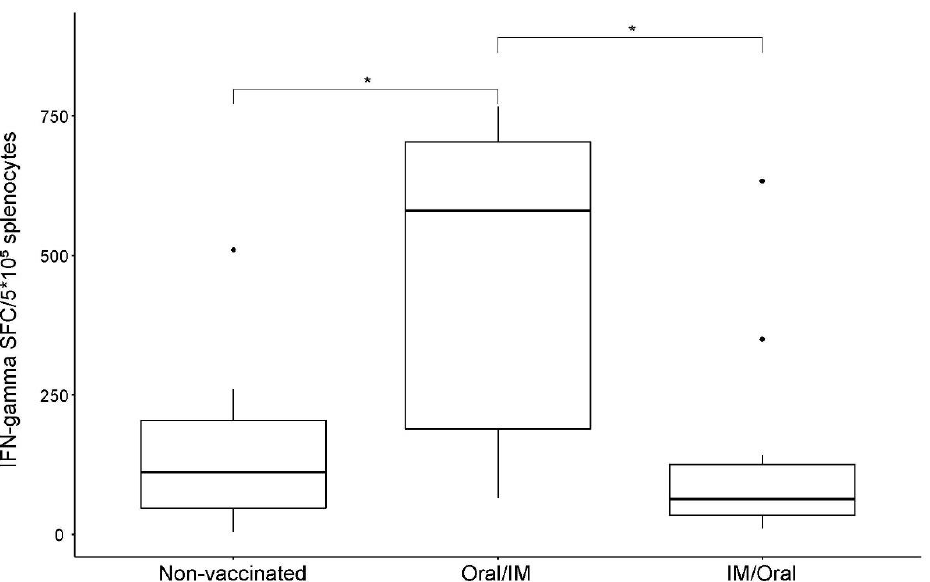
Figure 3. ELISpot analysis of stimulated T cells. Splenocytes collected after booster vaccination were added into chicken interferon- γ (ChIFN- γ) -coated wells and stimulated with soluble antigen for 32.5 h. The results represent the number of ChIFN- γ -secreting cells. PBS — non-vaccinated group; Oral/IM — prime-boost vaccinated group with the candidate strain via oral – intramuscular route; and IM/Oral — prime-boost vaccination with the candidate via intramuscular – oral route. * p < 0.05.